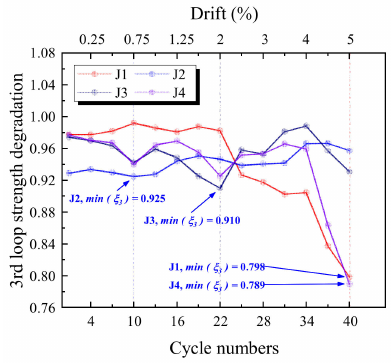
Figure 15. 3rd loop strength degradation